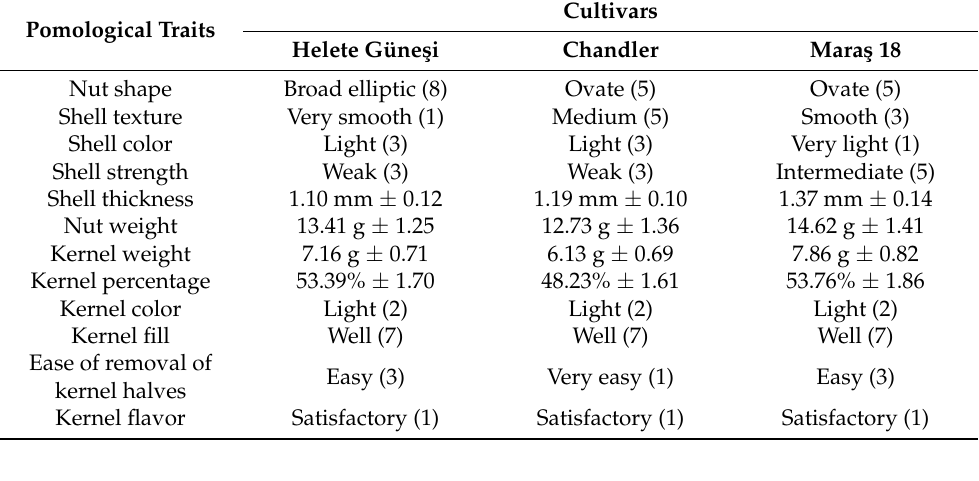
Table 4. Pomological traits of ‘Helete Güne¸si’ and its parents.